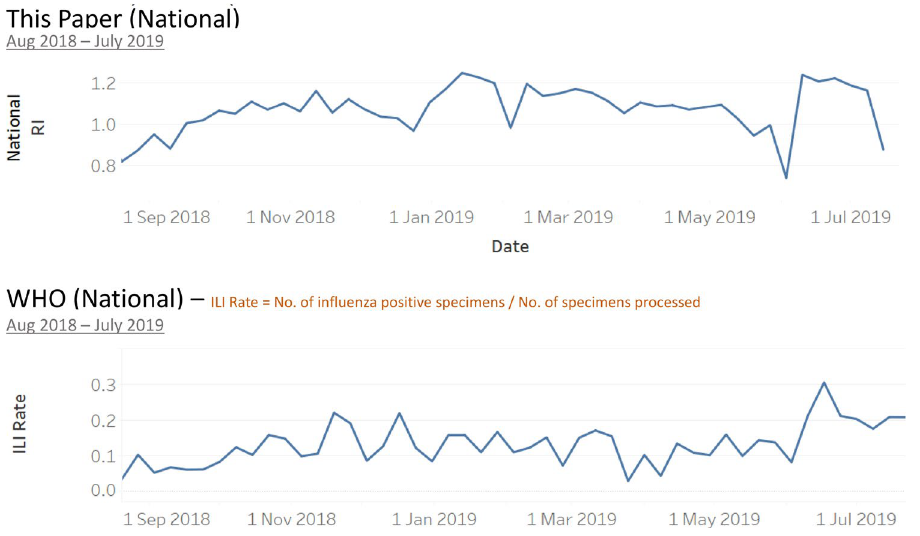
Figure 7. National level RI vs. WHO weekly influenza rate in the past 1